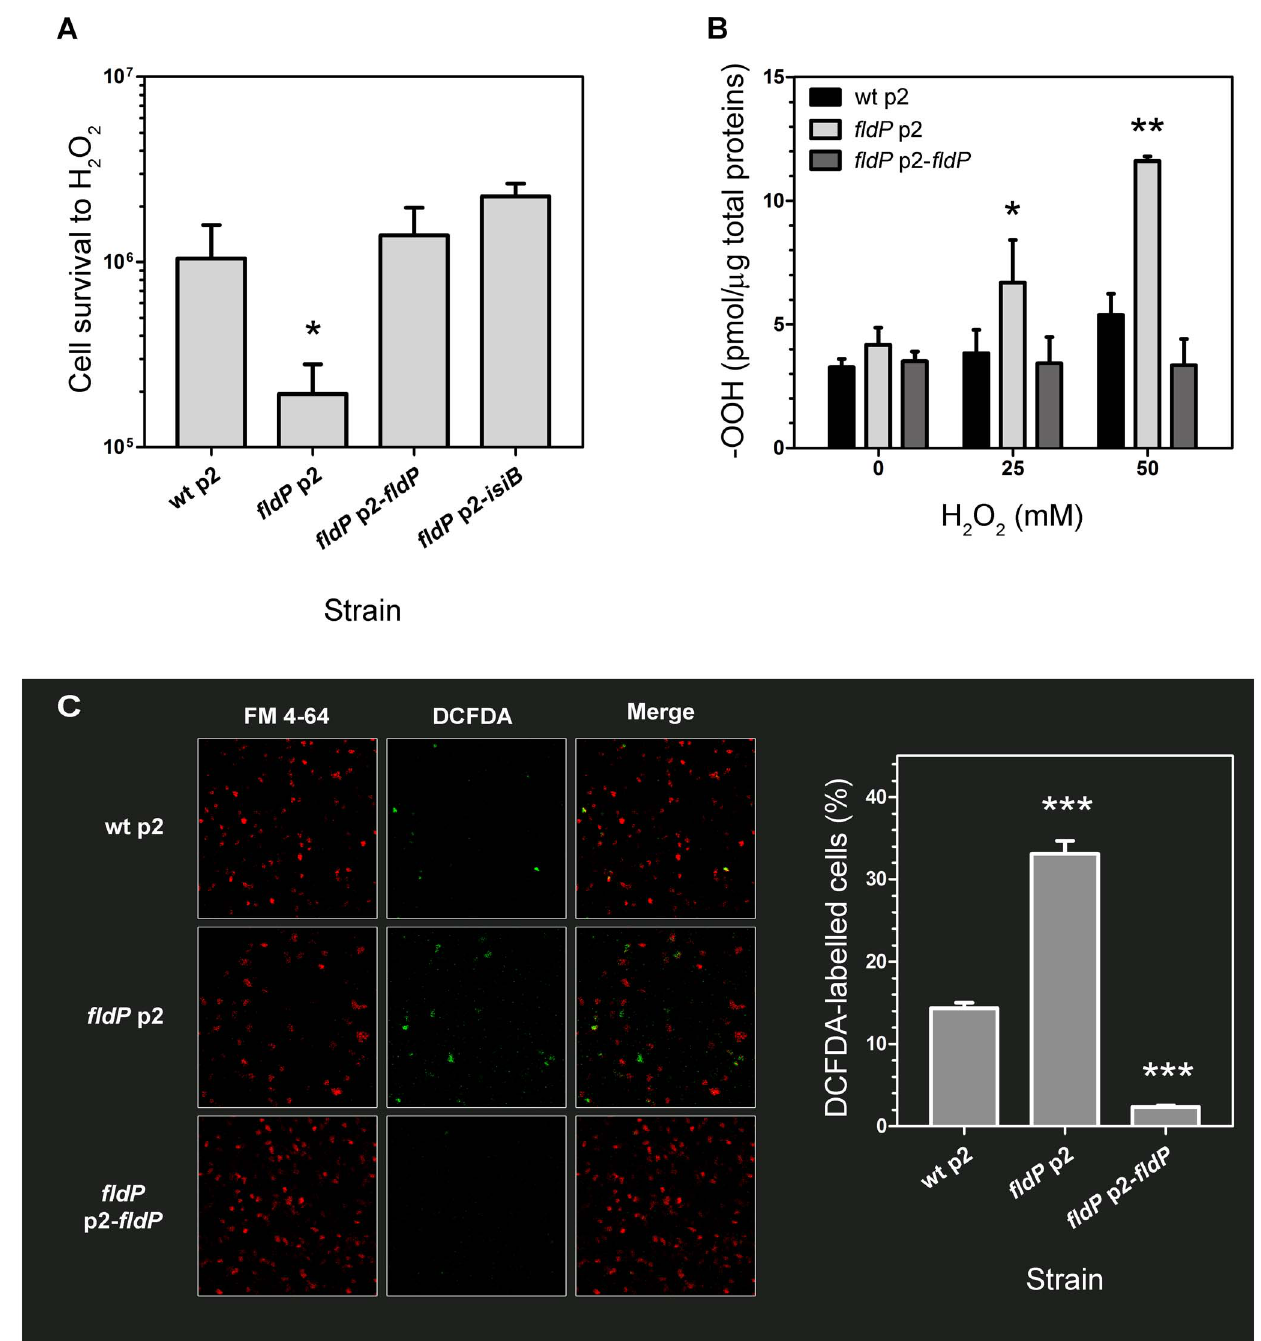
Figure 3. Role of FldP in cell survival and ROS accumulation upon exposure to H 2 O 2 . ( A ) Flavodoxin increases oxidative stress tolerance of P. aeruginosa exposed to H 2 O 2 . Cells from wt P. aeruginosa PA14 transformed with the empty plasmid p2, and from the isogenic fldP mutant strain harboring vectors p2, p2- fldP or p2- isiB were normalized to , 10 8 cells and then incubated with 50 mM H 2 O 2 for 30 min at 37 u C. Viability was estimated as described in Materials and Methods. ( B ) Expression of FldP prevents ROS build-up in stressed P. aeruginosa cells. Bacteria were exposed to the indicated concentrations of H 2 O 2 for 30 min, and total peroxides (-OOH) were determined in cleared extracts using the FOX II assay as described in the experimental section. Measurements in ( A ) and ( B ) were carried out in triplicate for two independent experiments, and the results are expressed as means with their SEM. Statistically significant differences P , 0.005 and P , 0.05 are identified by ** and *, respectively (one-tailed Mann-Whitney test). ( C ) Fluorescent detection of ROS formation in cells from wt, mutant and fldP -complemented strains challenged with 25 mM H 2 O 2 for 15 min, using a ROS-dependent fluorescent probe (DCFDA). Panels on the left show membrane fluorescence after staining with FM4-64; those on the middle depict ROS-dependent fluorescence, with the merges displayed in the right panels. Bars show percentages of ROS-stained cells relative to membrane-stained cells. Values presented are the means 6 SEM of 8–10 independent fields. Statistically significant differences respect to wt ( P , 0.0005) are identified by *** (one-tailed Mann-Whitney test).